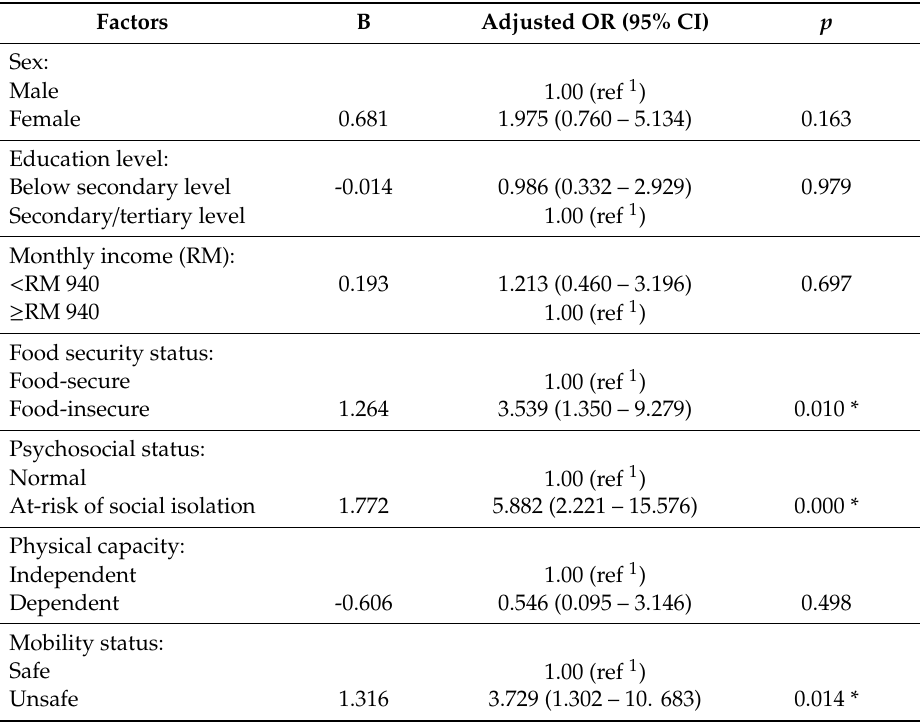
Table 3. Contributing factors to depression